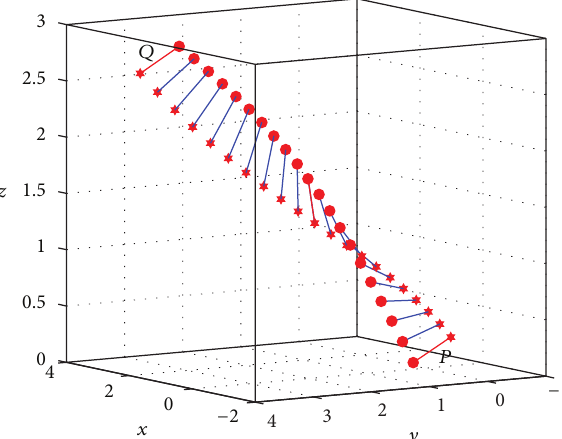
Figure 1: The rigid motion 𝐷(𝑡) from 𝑃 to 𝑄 .